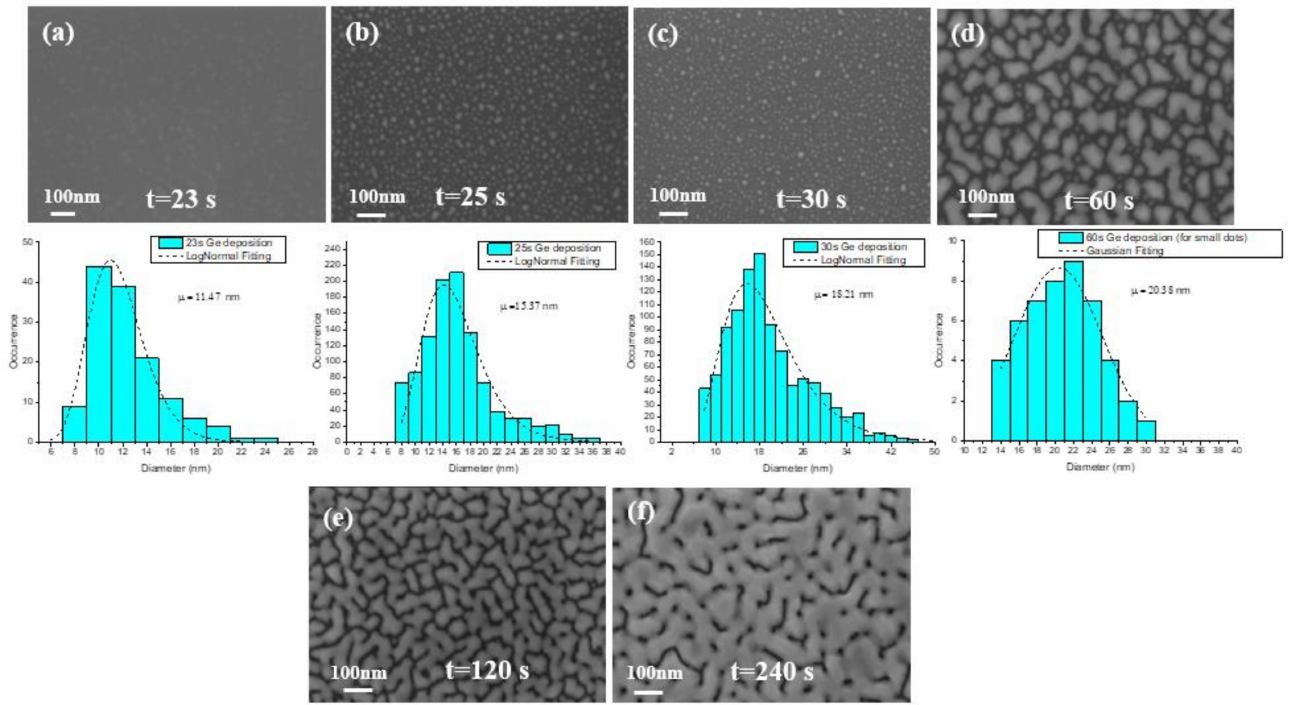
Figure 2. SEM images and histogram for deposition time of Ge ( a ) 23 s, ( b ) 25 s, ( c ) 30 s, ( d ) 60 s, ( e ) 120 s, and ( f ) 240